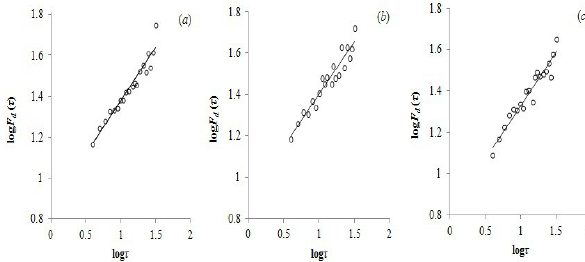
Fig. 4. Log-log plot (10-base logarithms) of the root-mean-square fluctuation function F d (τ) versus time interval τ (in years) for the shuffled annual mean LSAT anomalies dataset (a) globally with the best fit equation ( y = 0 . 51 x + 0 . 86 with R 2 = 0 . 94), (b) over the NH with the best fit equation ( y = 0 . 51 x + 0 . 89 with R 2 = 0 . 92), and (c) over the SH with the best fit equation ( y = 0 . 51 x + 0 . 82 with R 2 = 0 . 93).